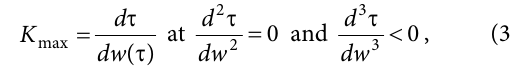
Fig. 2. Schematic of a three layer ANN with four neurons in the input layer, three neurons in the hidden layer and one neuron in the output layer (Miradi